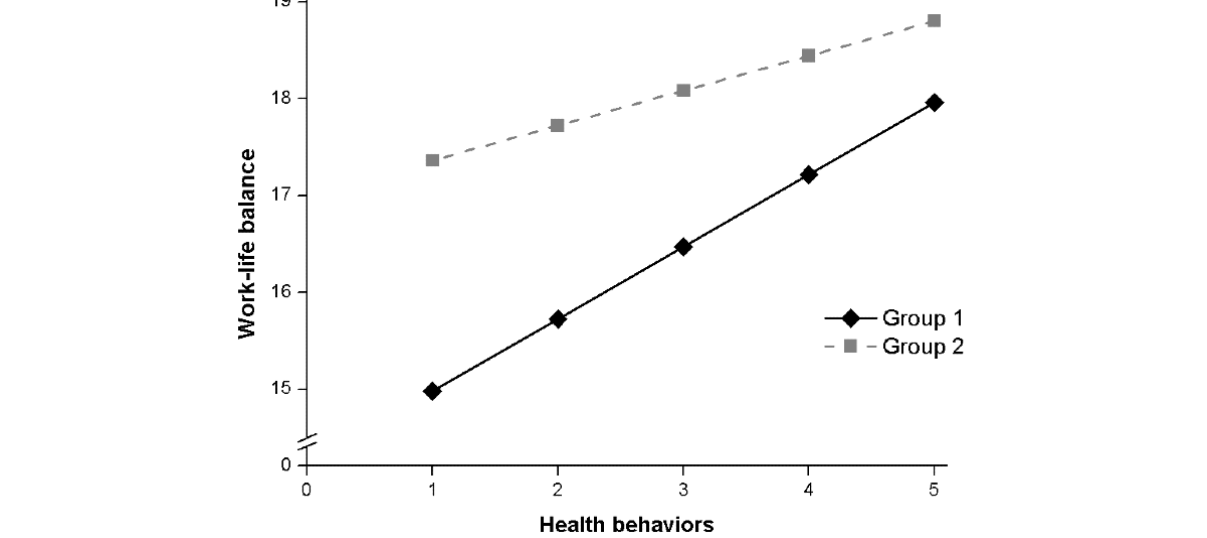
Figure 3. Interaction of health behaviors and residence on work-life balance (Group 1: residents in Germany; Group 2: residents in